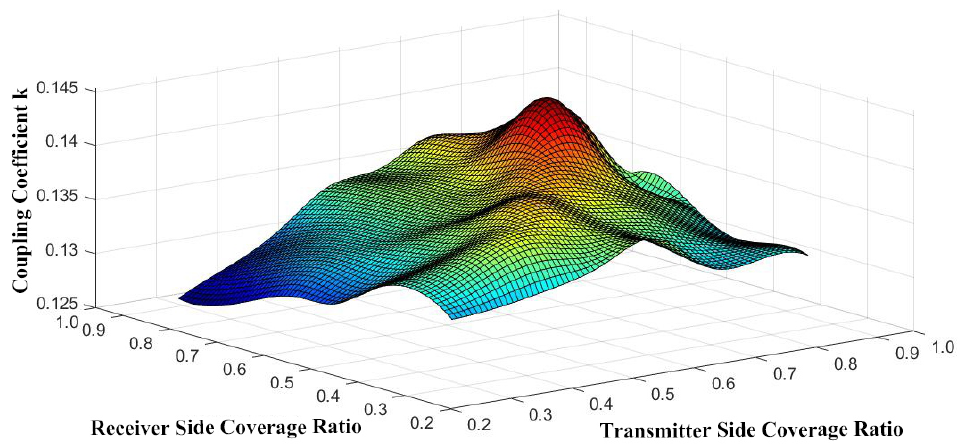
Figure 9. Magnetic coupling variation under various covering ratios.